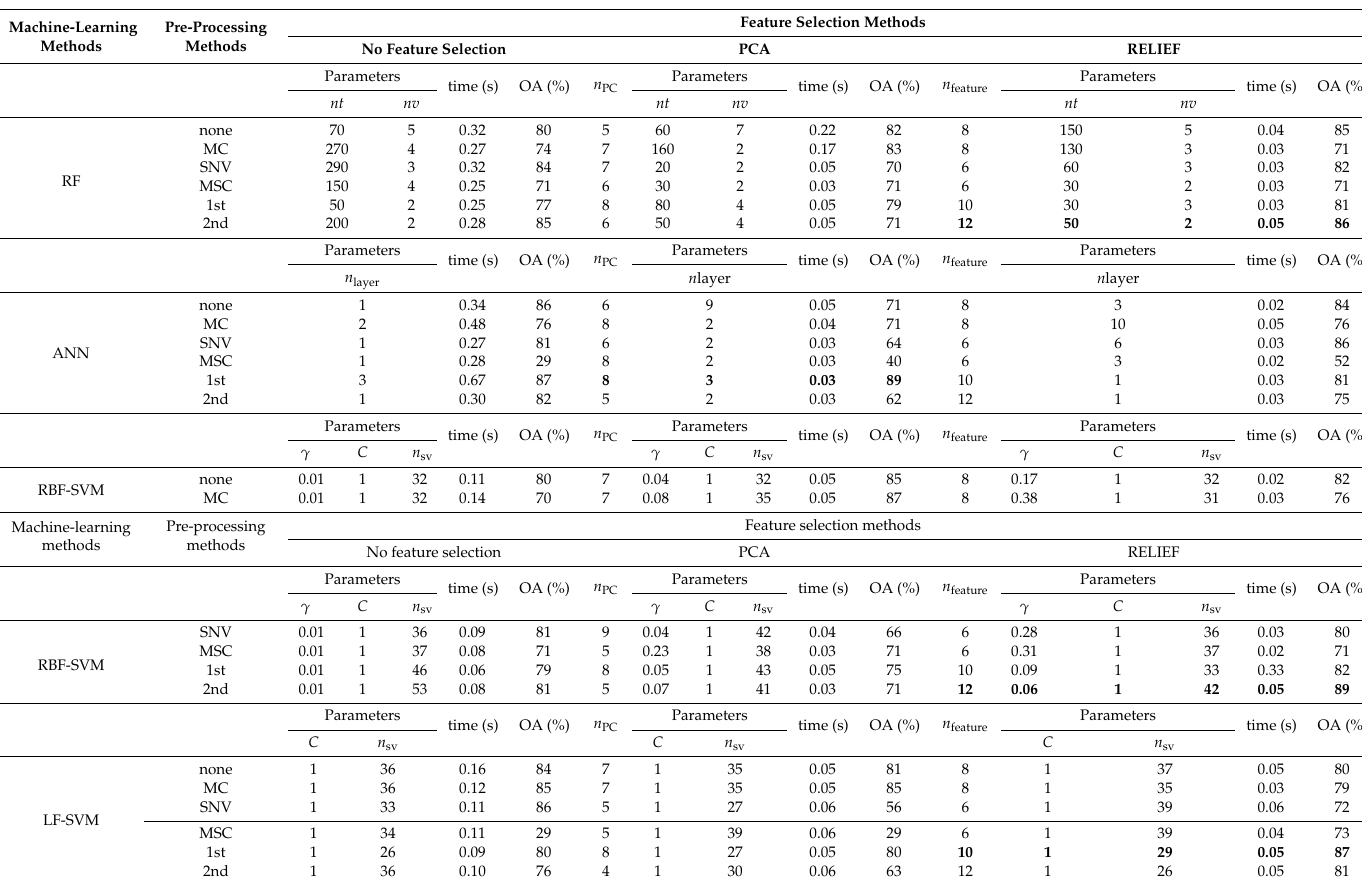
Table 4. The operation times, parameter setting, and overall accuracies for diagnosis models by using different pre-processing, feature selection and machine- learning methods 1